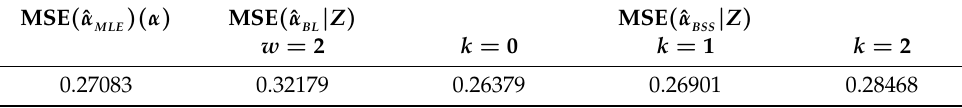
Table 7. Results of calculated MSE for ˆ α .